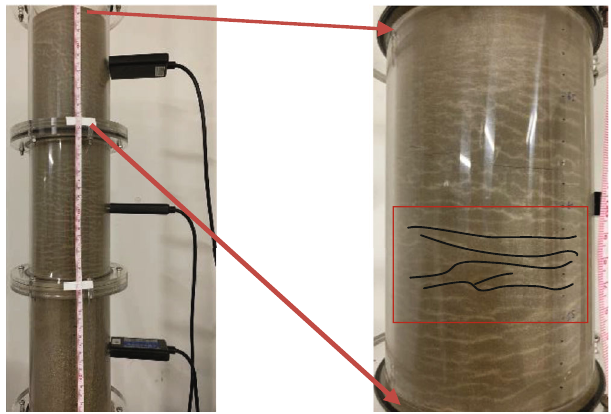
Figure 13: Discontinuous capillary